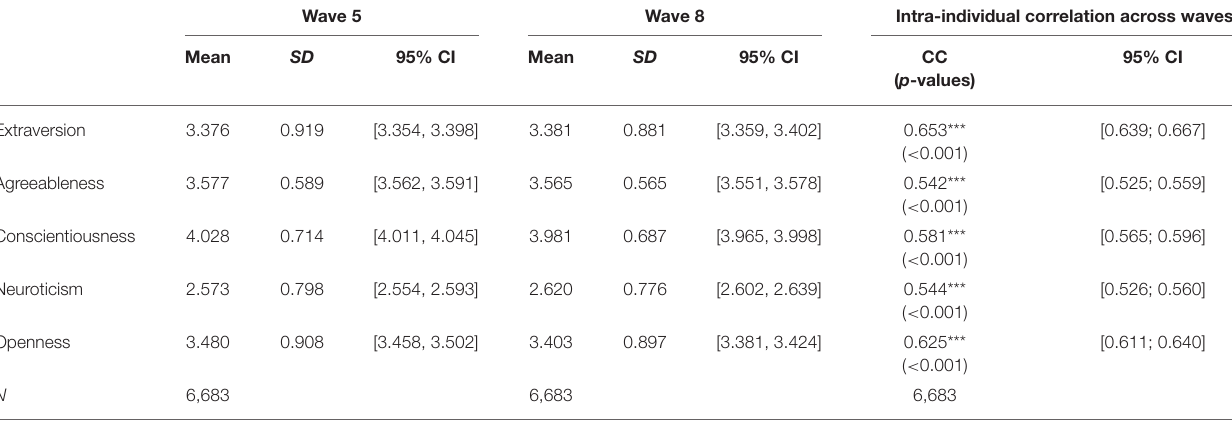
TABLE 4 | Means, standard deviations and intra-individual correlations of the Big Five Personality Dimensions.